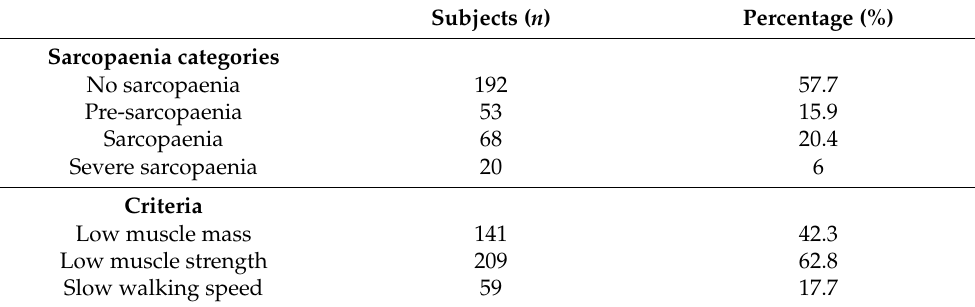
Table 2. Sarcopaenia categories and criteria according to EWGSOP ( n = 333).